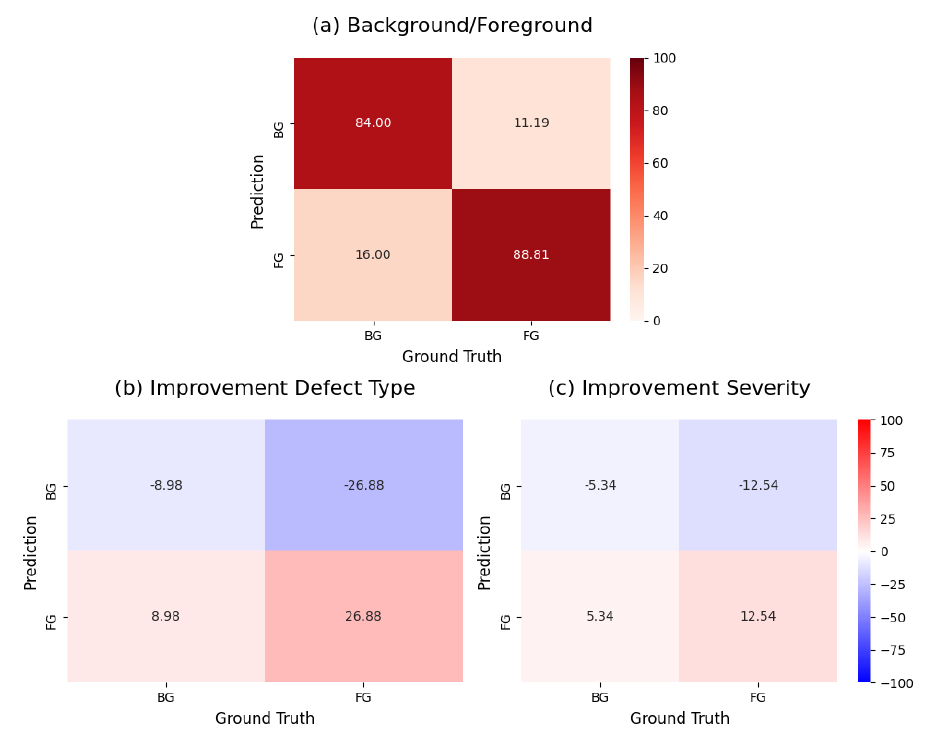
Figure 12. Confusion matrices for the multi-branch model. ( a ) Confusion matrix of the multi-branch model for the background/foreground task. ( b , c ) Confusion matrix difference between the current confusion matrix and the matrices from the single task defect type and severity models displayed in Figures 8 and 9. It is clear that the multi-branch model performs better than the two single-task models on the background/foreground task.